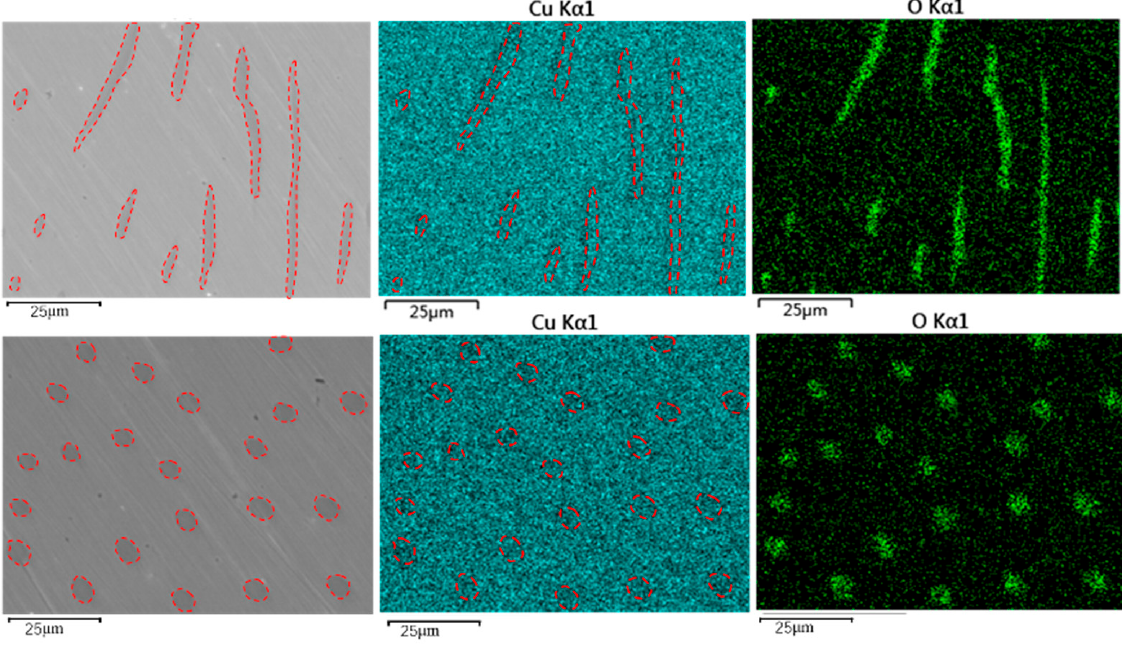
Figure 6. SEM morphology of microwave-sintered Cu-rGO composites.